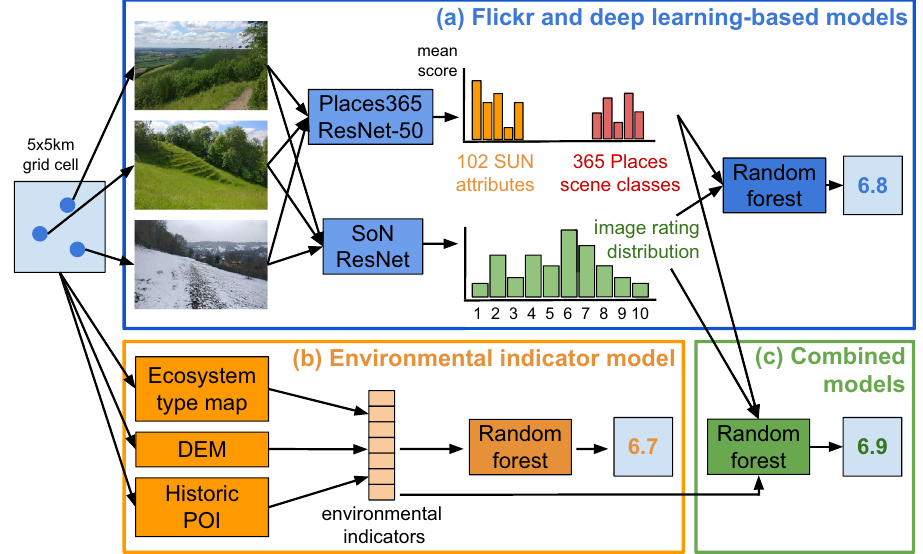
Figure 6. The main study design comparing spatial predictions of scenicness at a 5 × 5 km grid cell resolution using random forests. These used different combinations of variables based on ( a ) the predictions of two deep learning models on Flickr images, ( b ) a set of environmental indicators, and ( c ) combinations of the two. Photos © Alun Ward (cc-